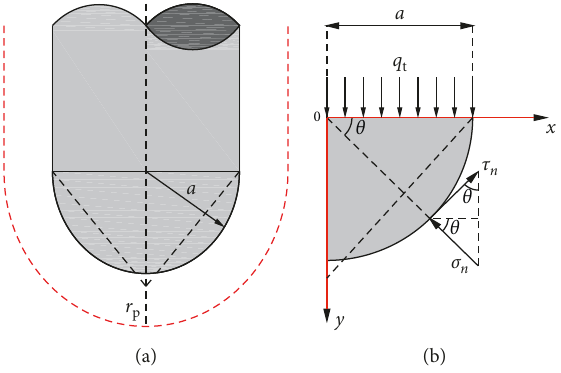
Figure 5: The diagram of cone force